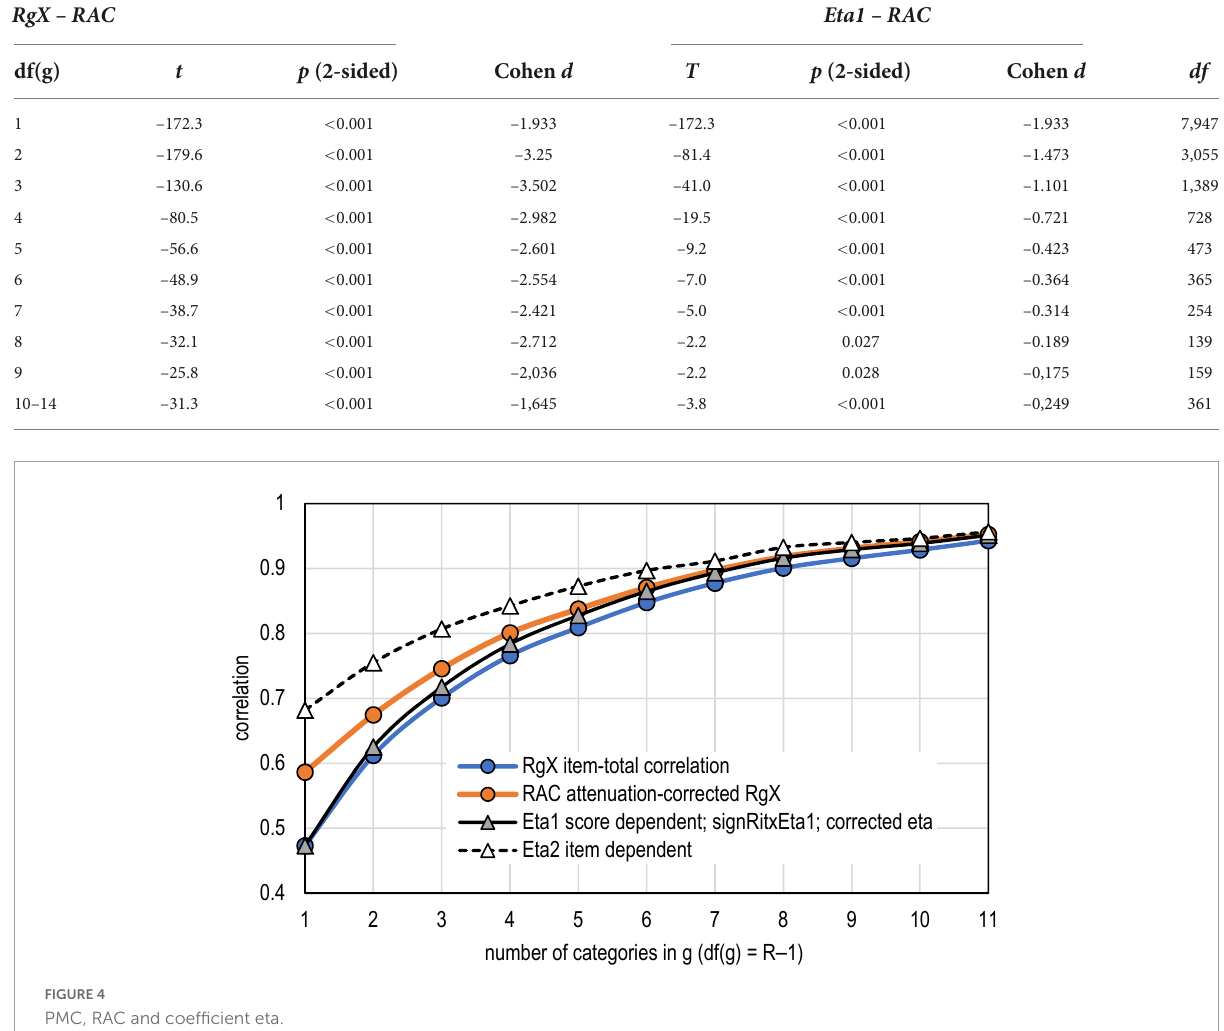
FIGURE4 PMC, RAC and coefficient